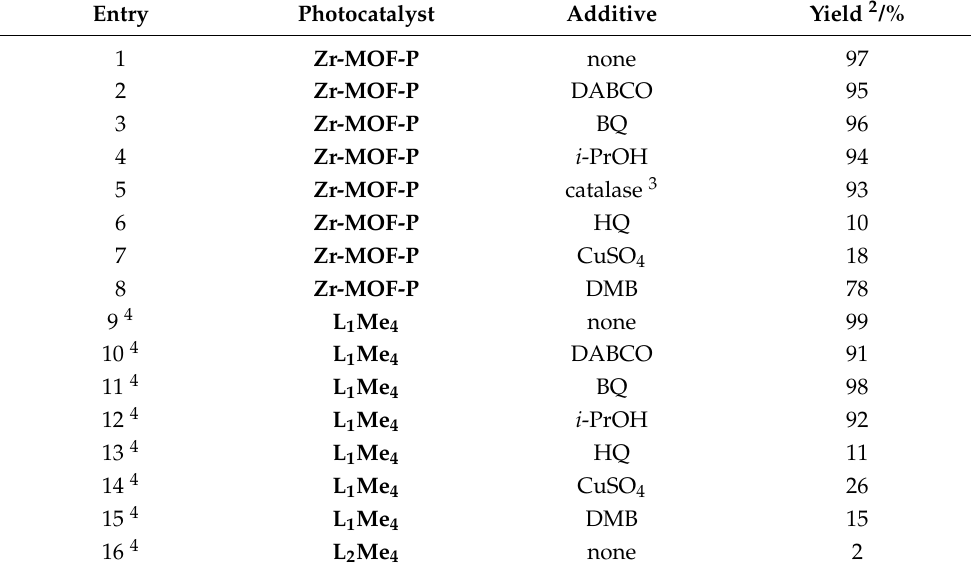
Table 2. Quenching experiments 1